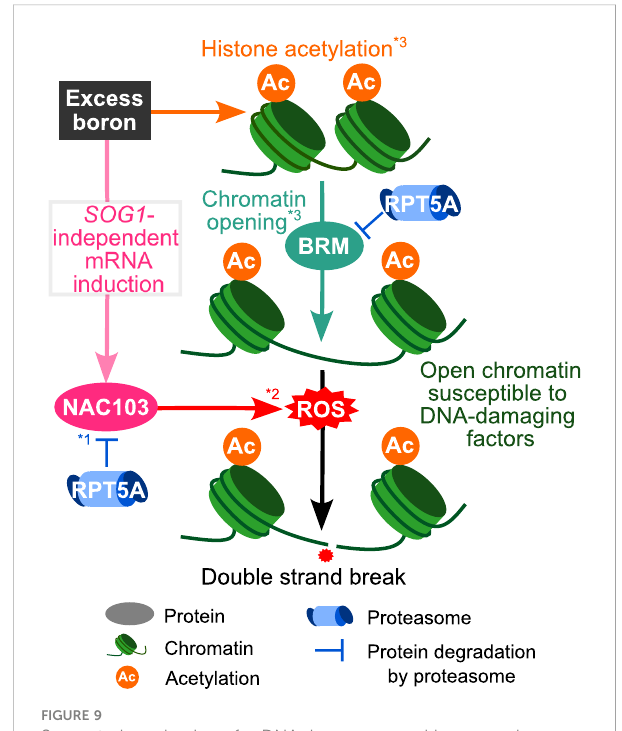
FIGURE 9 Suggested mechanisms for DNA damage caused by excess boron stress in wild type plants. Excess boron stress induces NAC103 mRNA in SOG1 -independent manner. As NAC103 protein is degraded via proteasome pathway (* 1 Sun et al., 2013), mutation in proteasome (RPT5A) should result in over-accumulation of NAC103 protein. Over-accumulation of NAC103 is likely to induce ROS accumulation (* 2 Niu et al., 2014). ROS is a major cause of DNA damage. Together with the known BRAHMA(BRM)-dependent pathway in which excess boron stress induces histone acetylation to loosen chromatin, making DNA susceptible to DNA-damaging factors (* 3 Sakamoto et al., 2018), the NAC103 dependent pathway plays a crucial role in growth defects under excess boron